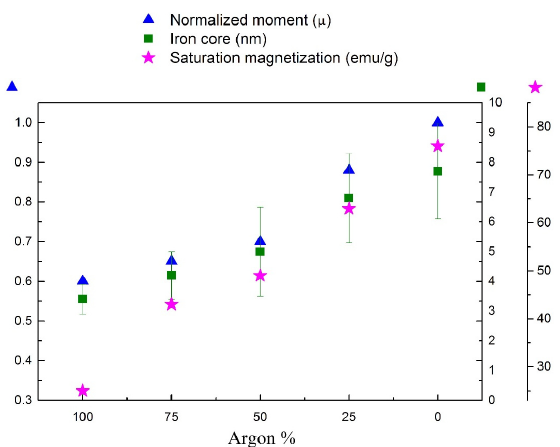
Figure 6. Effects of iron core sizes on normalized moment ( μ ) and saturation magnetization (emu/g) versus argon gas percentage. The error bars correspond to iron core size dispersion.